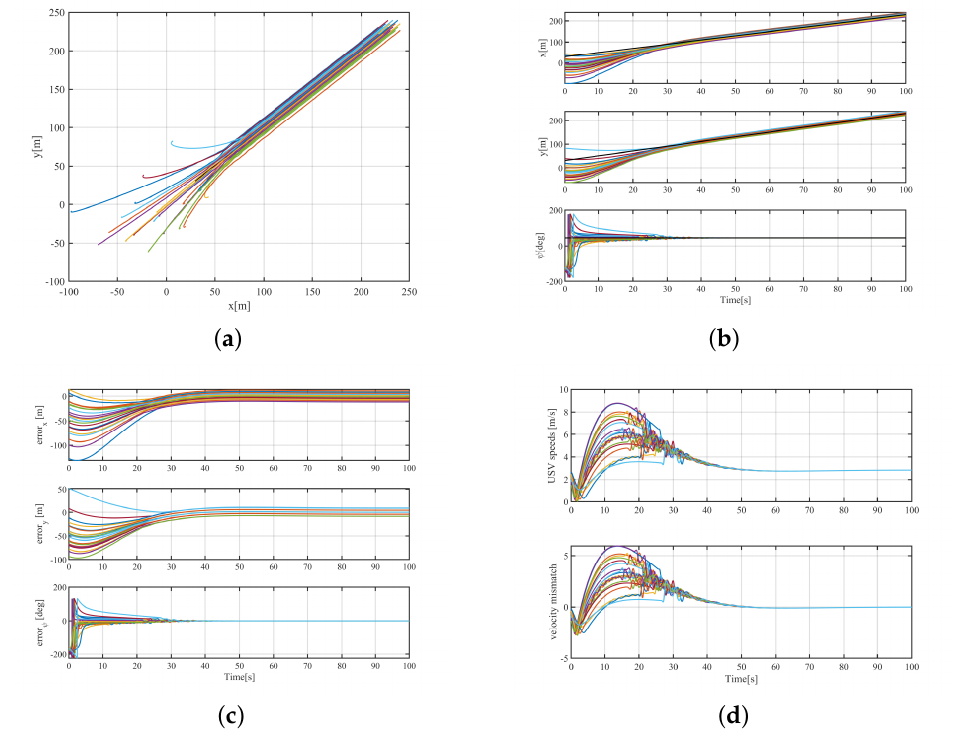
Figure 9. The simulation results using DSCA of Case 1. ( a ) Trajectories. ( b ) Positions and headings. ( c ) Tracking errors. ( d ) USV speeds and velocity